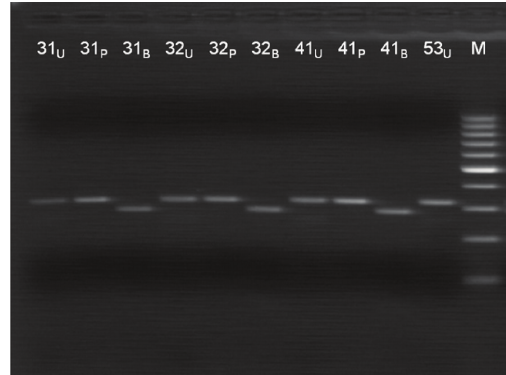
Figure 2: An overview of results obtained with N34S Restriction fragment length polymorphism analysis. Samples 31, 32, 41, and 53 are wild types. U undigested PCR product, P CR product digested with Pst I, B CR product digested with Bsr DI.